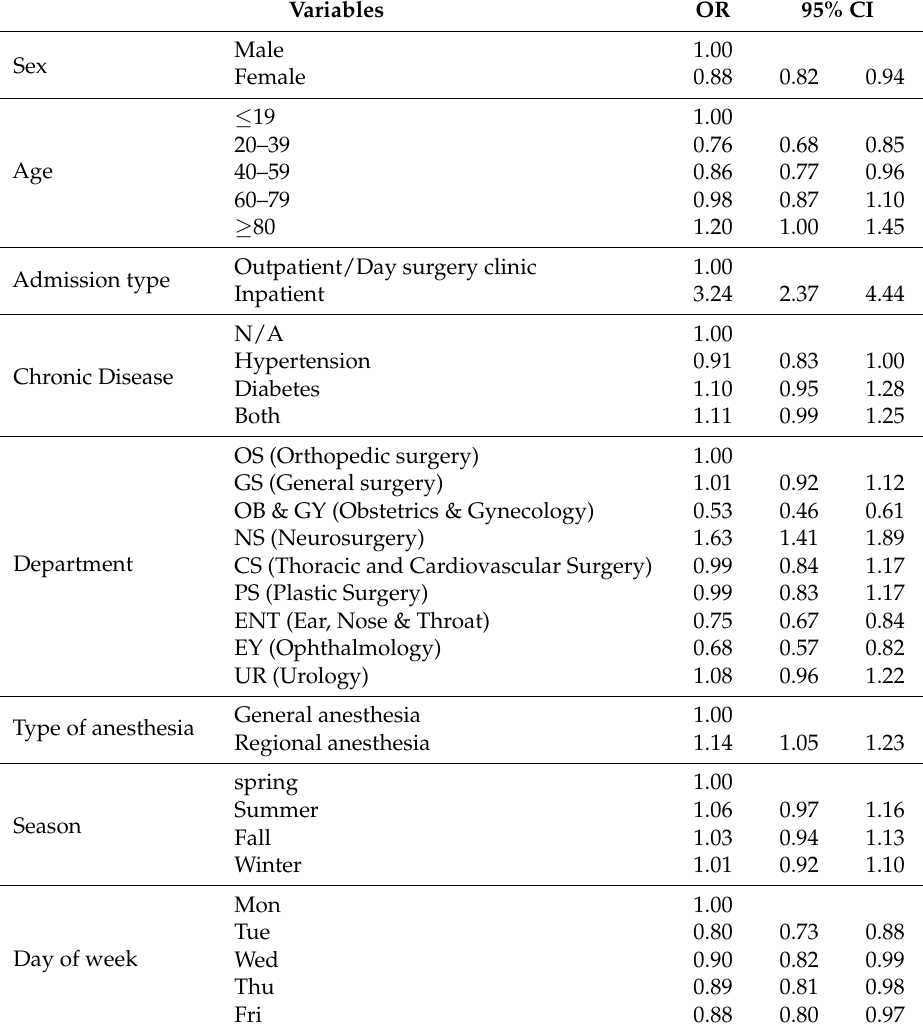
Table 4. Multivariable regression of the association with surgery cancellation and related factors (Planned